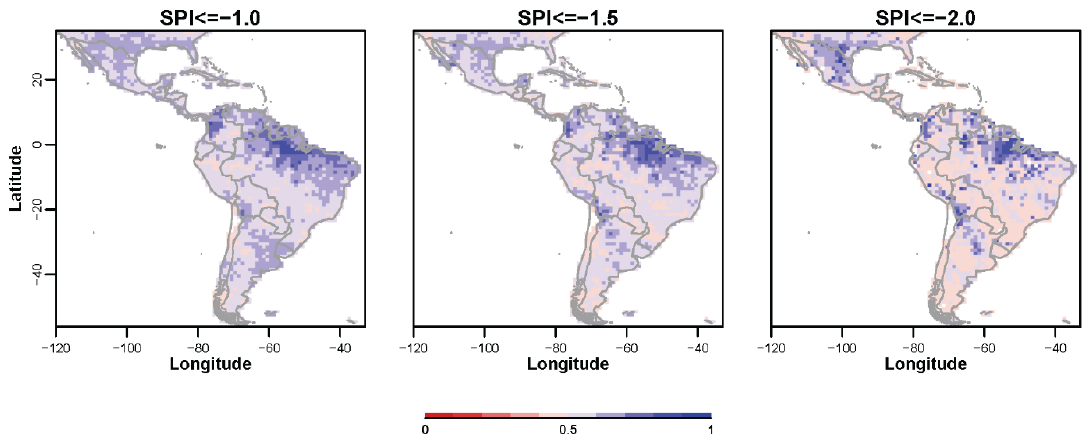
Figure 9. Area under the ROC curve for the probability of drought detection at different SPI6 frequencies. Values indicated in the color bar are estimated at lead time of 6 months for the hindcast period 1981–2010.